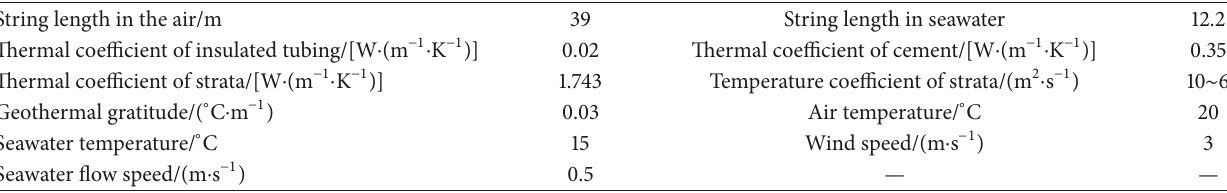
Figure 1: Well structure. Table 2: Environmental parameter.